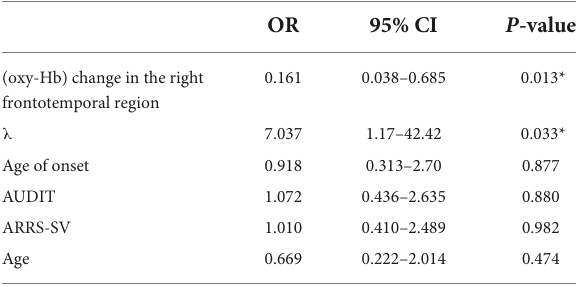
TABLE 3 A logistic analysis of the factors associated with a relapse. Presense of relapse OR 95% CI P -value (oxy-Hb) change in the right frontotemporal